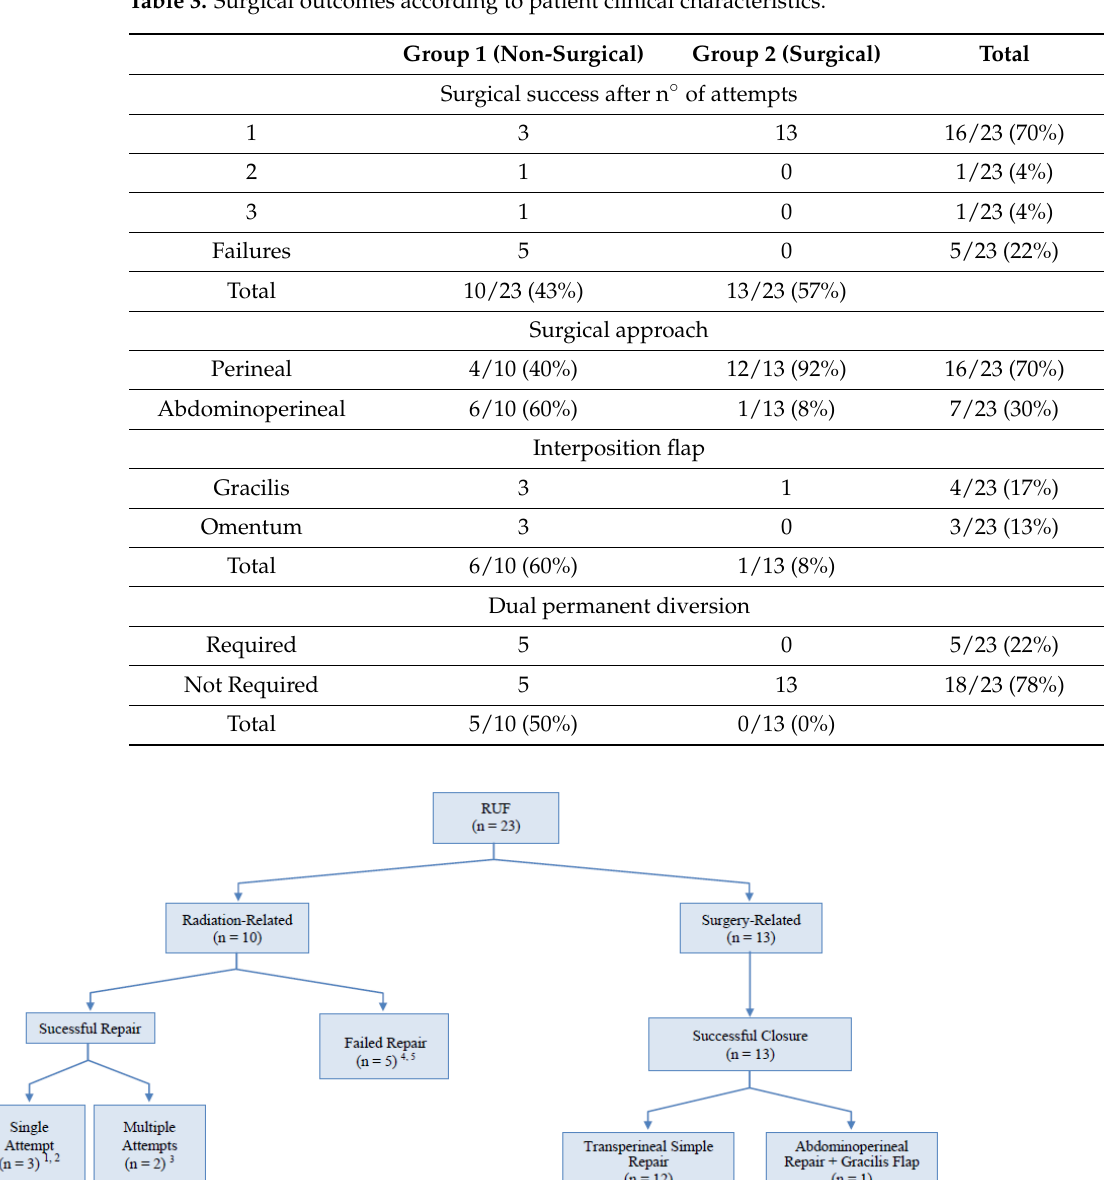
Figure 1. Algorithm of surgical management of RUF followed in our study. 1 One transperineal repair + gracilis; 2 two abdominoperineal repairs (one gracilis; one omentum); 3 two abdominoperineal repairs (both omentum); 4 three transperineal repairs (one Gracilis; two none); 5 two abdominoperineal repairs (one none; one glubran). Two surgical approaches were used: transperineal in 16/23 (70%) patients and ab- dominoperineal in 7/23 (30%) based on the local tissue integrity, fistula characteristics, previous radiation/energy-ablation exposure, bowel and bladder function including the sta- tus of the urethra and preoperative continence and the presence of pelvic sepsis. Of a total